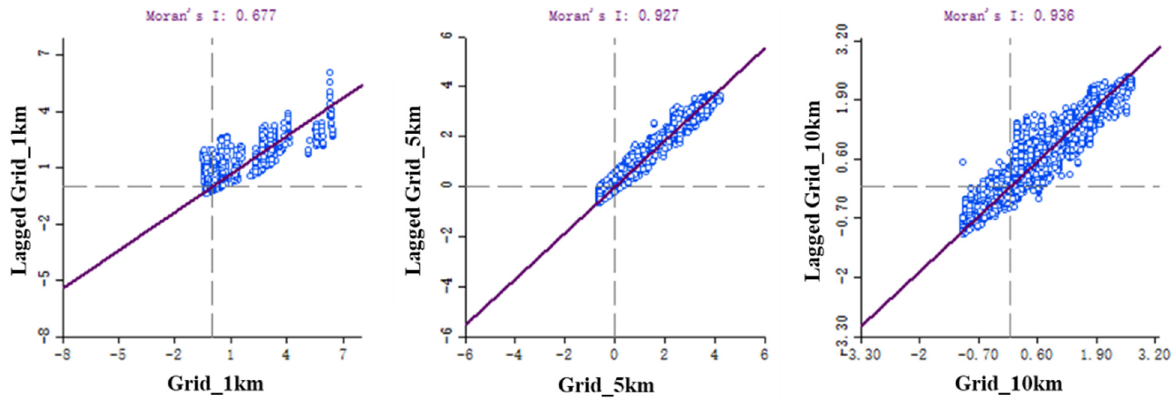
Figure 6. Moran’s I index for different spatial resolutions.